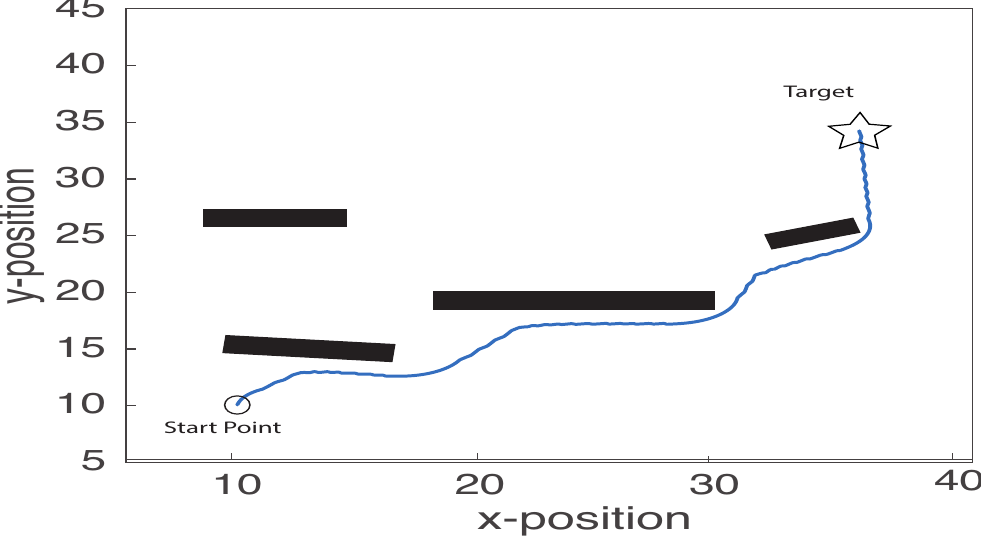
Figure 10. Path of the robot for state 2, the Front-Left motor is